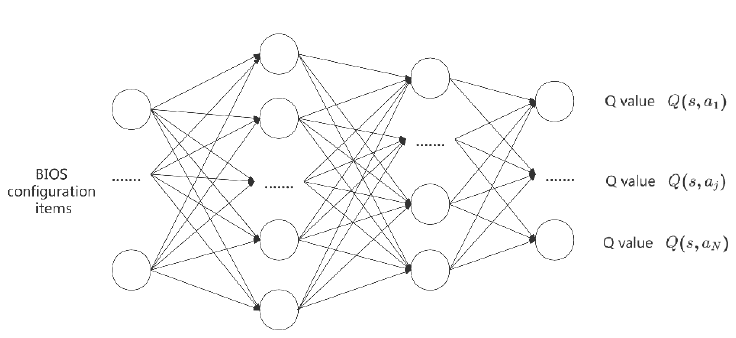
Figure 4. Schematic illustration of the q-network. Algorithm 1 BIOS optimization algorithm based on DQN (Part 1).